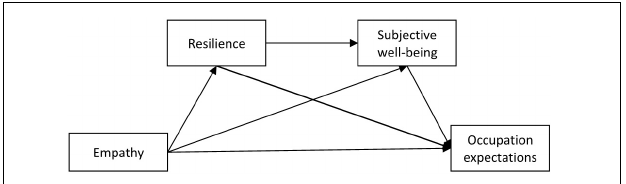
FIGURE 1 | A hypothetical sequential mediating model diagram.